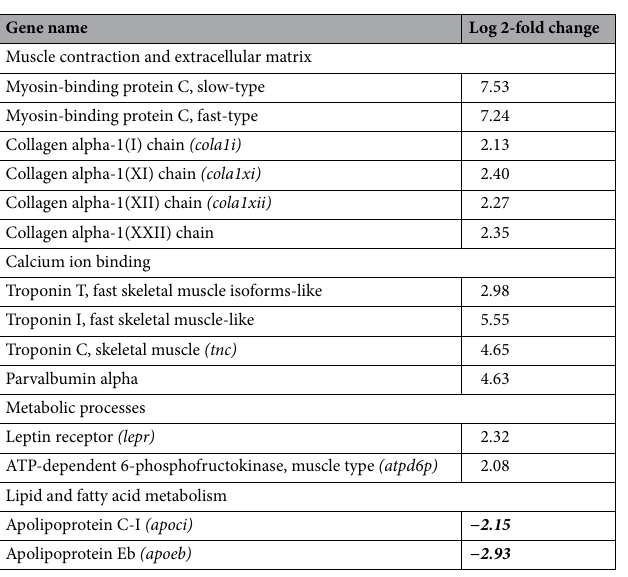
Table 2. The expression of key DEGs in the FD muscle region when comparing HN: High red color-no banding fish and HB: High red color-banded fish; downregulated genes in HN fish are highlighted in bold